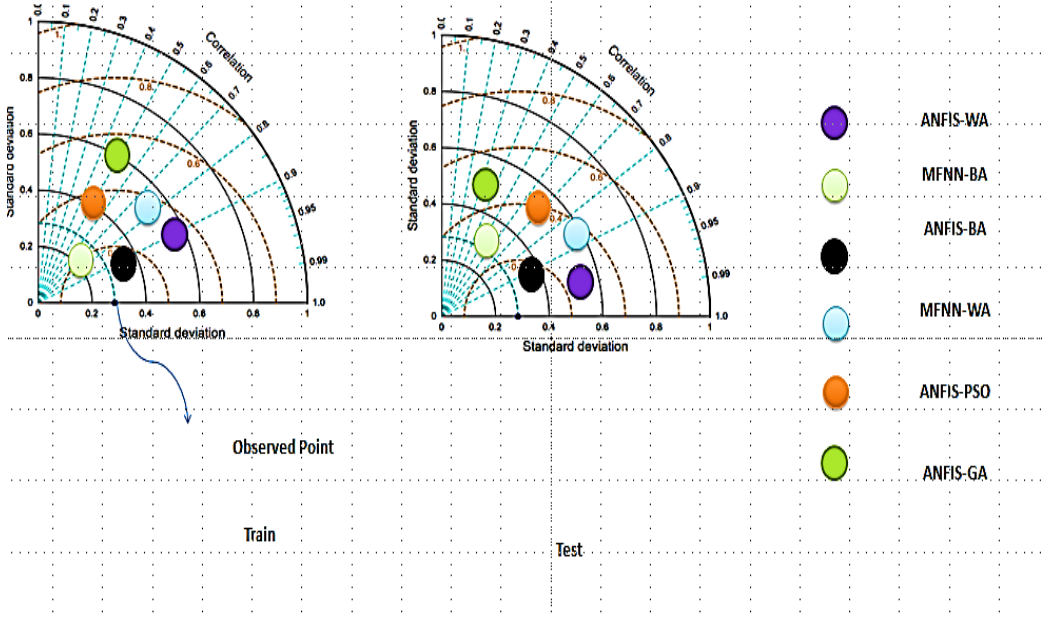
Figure 13. Computation of Nash–Sutcliff efficiency (NSE).